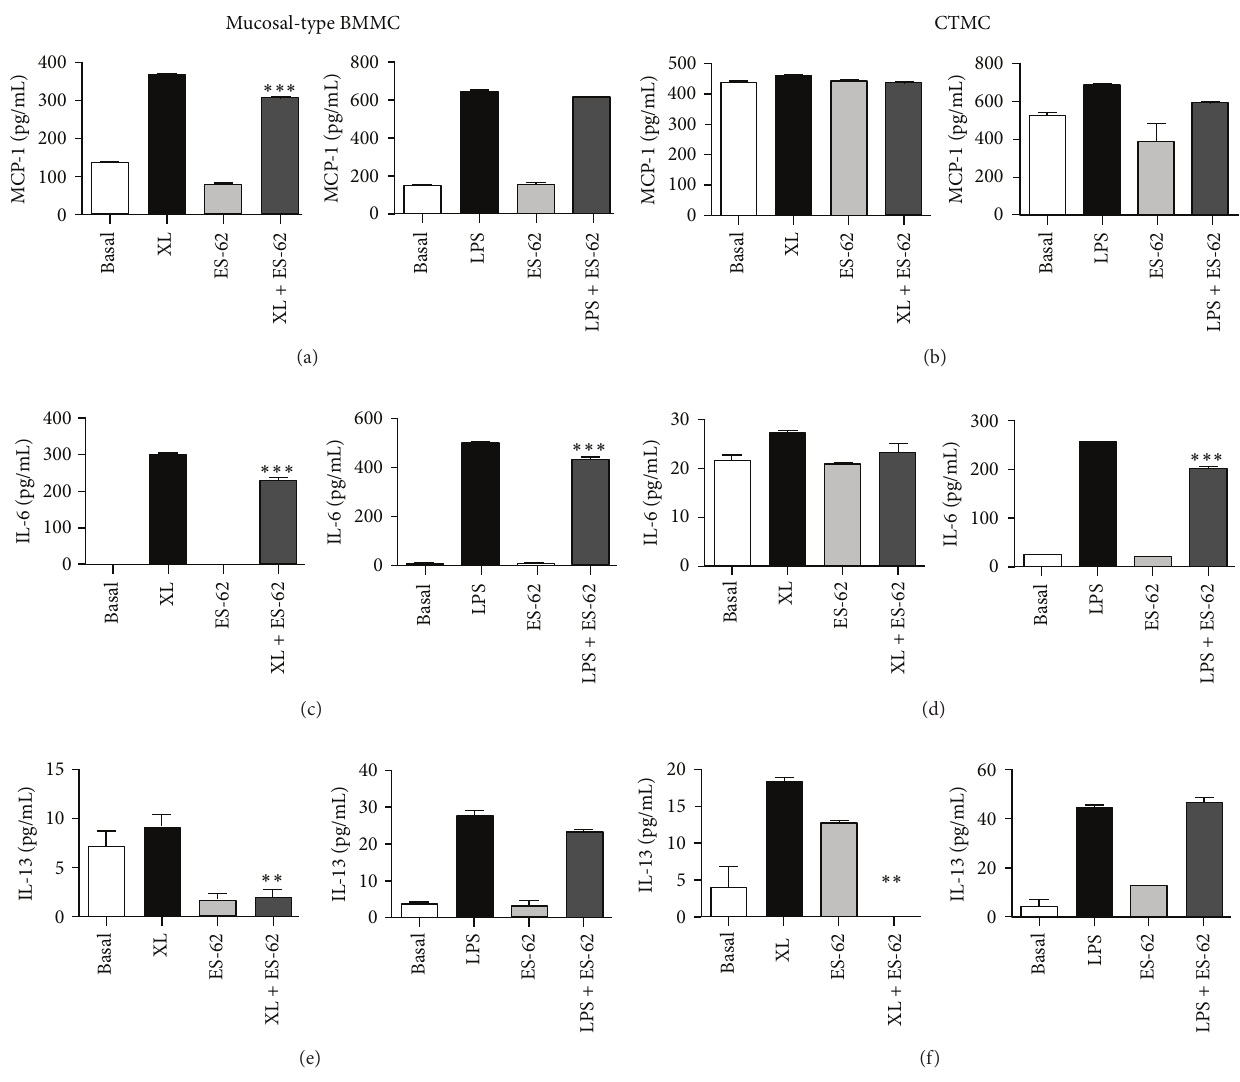
Figure 3: Chemokine and cytokine release by mast cell subsets. Mucosal-type BMMC (a), (c) & (e) and CTMC (b), (d) & (f) were sensitised with murine anti-DNP IgE (0.5 𝜇 g/mL) in the presence and absence of ES-62 (2 𝜇 g/mL) overnight. Cells were then stimulated with DNP (0.5 𝜇 g/mL) to induce Fc 𝜀 RI cross-linking (XL) or LPS (0.5 𝜇 g/mL) for 24h at 37 ∘ C and MCP-1 (a) & (b), IL-6 (c) & (d), and IL-13 (e) & (f) release measured by ELISA. The data presented are single experiments representative of at least 2 independent experiments apart from the IL-13 release from CTMC, which could only be detected in a single